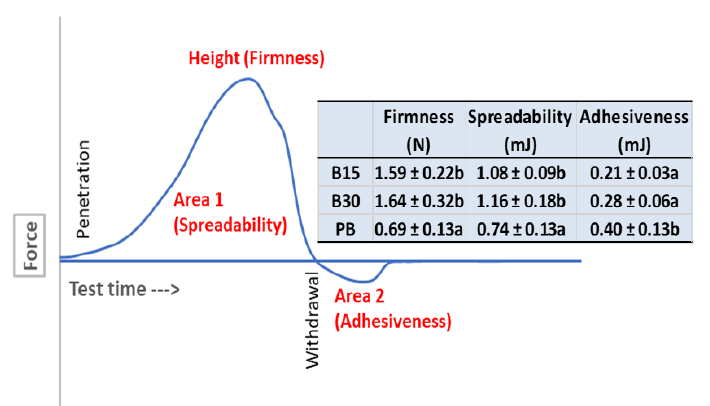
Figure 3. The characteristic force–deformation curve of butter samples and the measurement of the three texture parameters. B15 and B30, cottonseed butter made from glandless cottonseed kernels roasted at 150 ◦ C for 15 and 30 min, respectively. PB, commercial Skippy creamy peanut butter. Data are present in the format of average ± standard deviation ( n = 3). Different letters in the same column indicate these values statistically significantly different ( p ≤ 0.05).